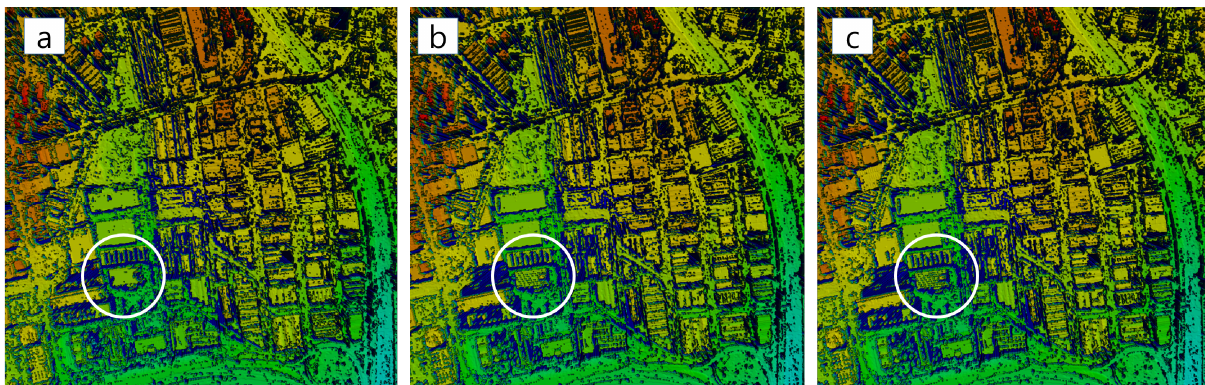
Figure 7. DSM results by search window (a: Fixed size search window (size: 13); b: Multi-dimensional search window; c: Multi- dimensional search window using line